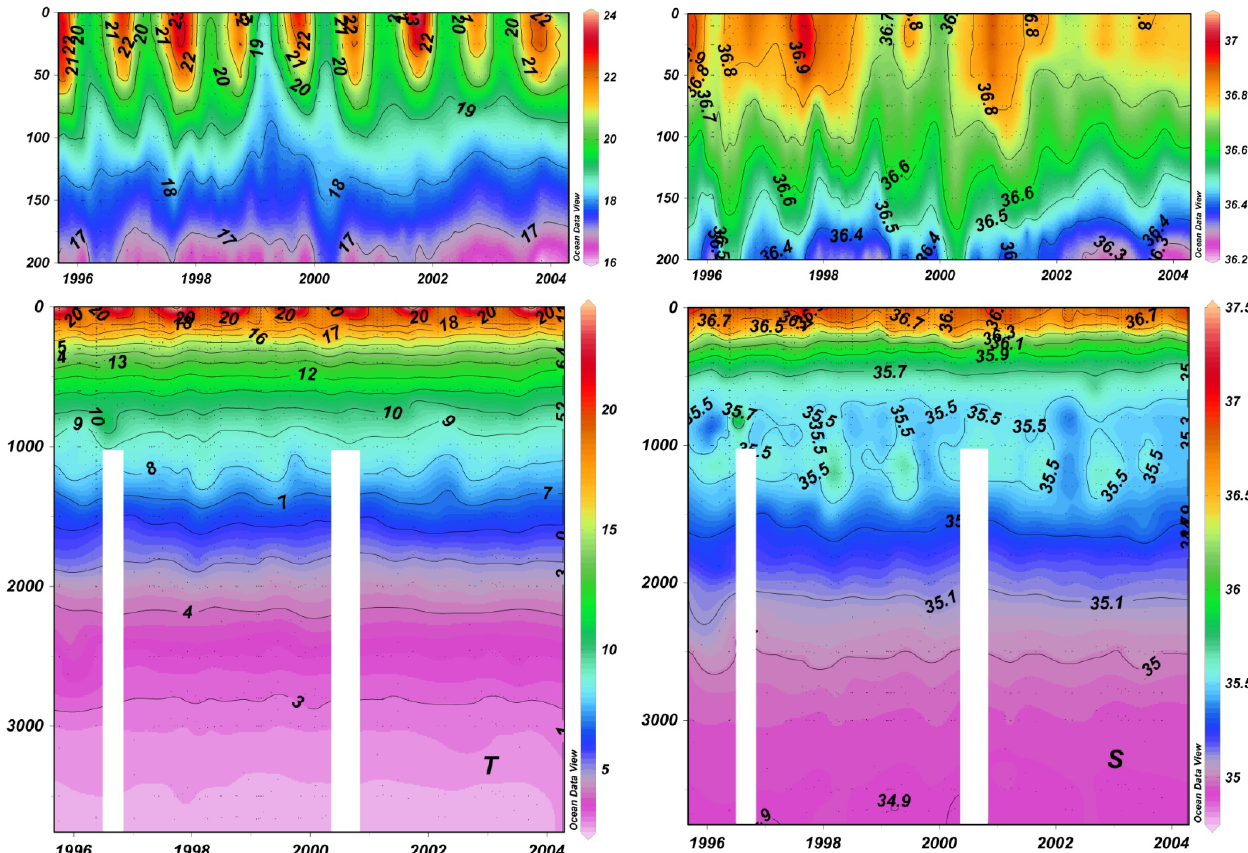
Fig. 2. Hovm¨oller diagram of water column temperature ( ◦ C), salinity, pH in total scale at in situ conditions, pH Tis , and C T (µmolkg − 1 ) for the period from September 1995 to February